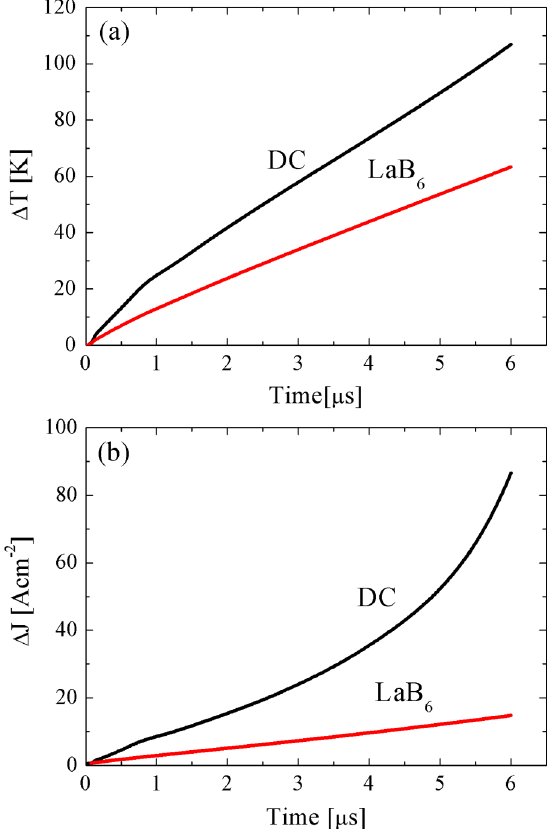
FIG. 4. Comparison of the stopping range (a) and the deposited heat power (b) as a function of BB electron energy. (c) The deposited energy at different BB electron energies as a function of the range in the cathode.